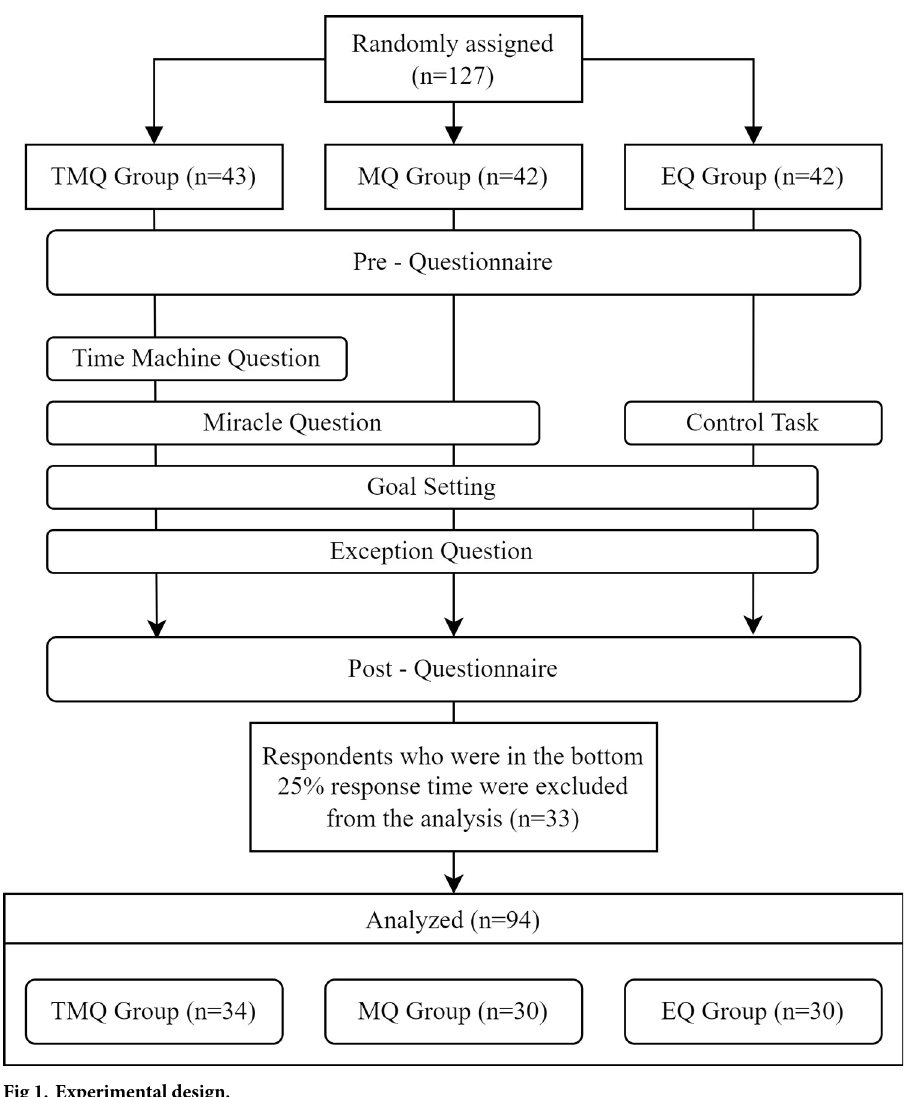
Fig 1. Experimental